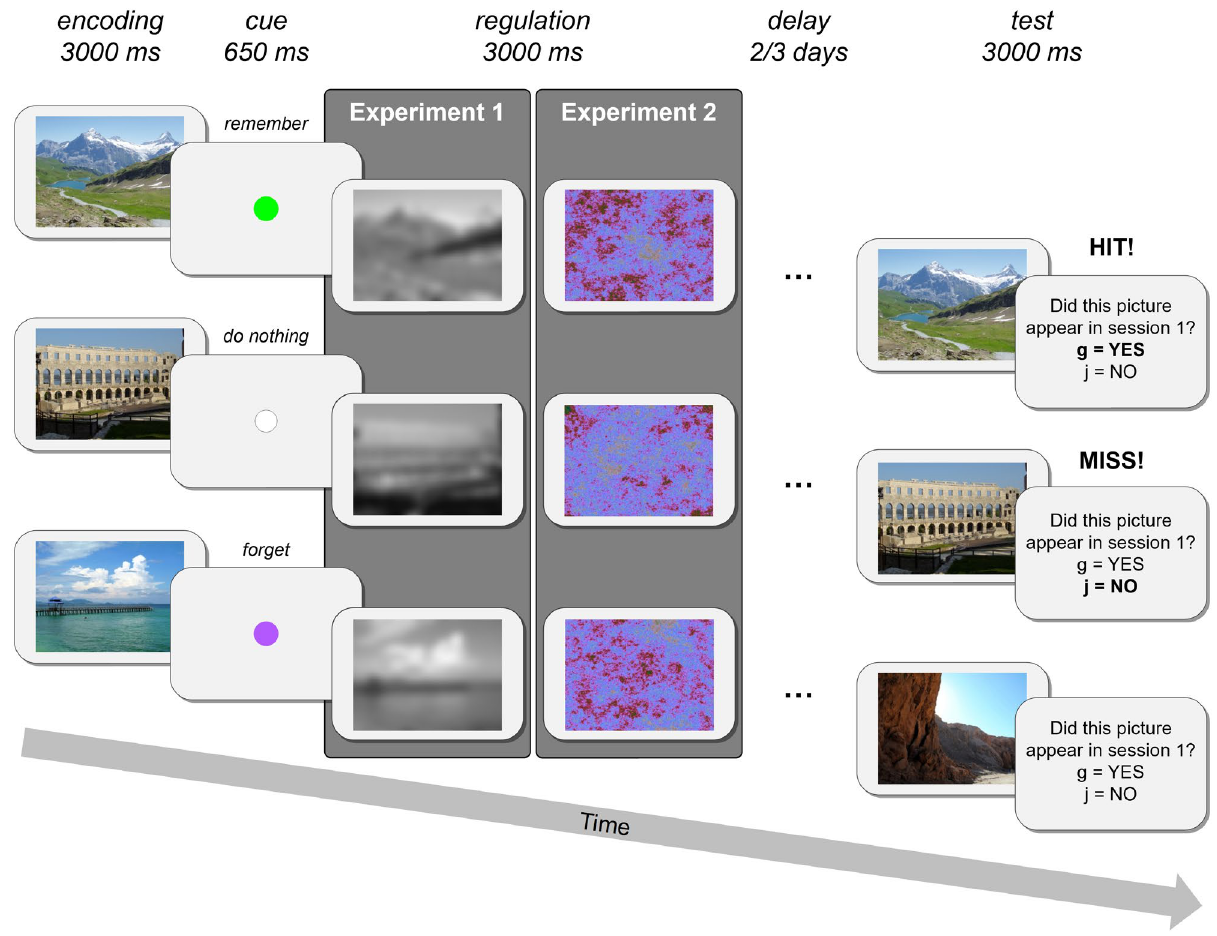
Figure 1. Sequence of events during a remember (green cue), control (white cue), and forget (purple cue) trial of Experiment 1 and Experiment 2. Both experiments entailed two experimental sessions which were